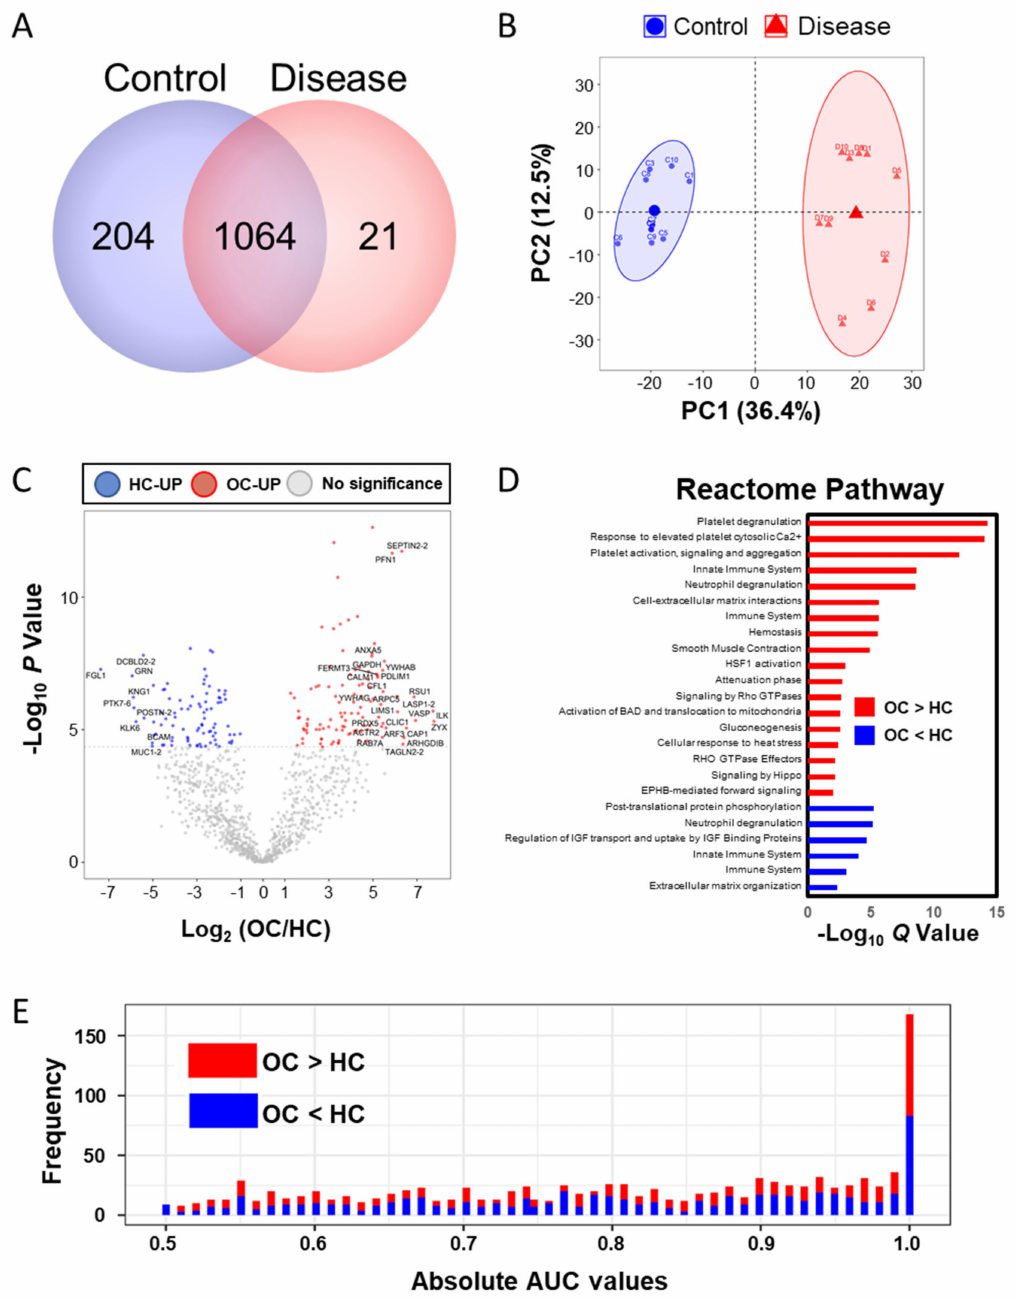
Figure 2. Proteomic analysis by LC–MS / MS. ( A ) The number of identified proteins in the two groups (control and disease); ( B ) PCA analysis result of the plasma proteins; ( C ) volcano plot of the plasma proteomic data; red circles are less than the Bonferroni corrected p -value < 0.05, indicating a significantly increased 108 proteins in OC. Blue circles are less than a Bonferroni-corrected p -value < 0.05, indicating a significantly increased 89 proteins in HC. ( D ) Reactome pathway enrichment analysis; red bar indicates that the pathways were enriched in the upregulated proteins in OC, and blue indicates that the pathways are enriched in the upregulated proteins in HC. The size of the bar is the Q value. ( E ) Histogram of 1124 absolute area under curve values in univariate ROC